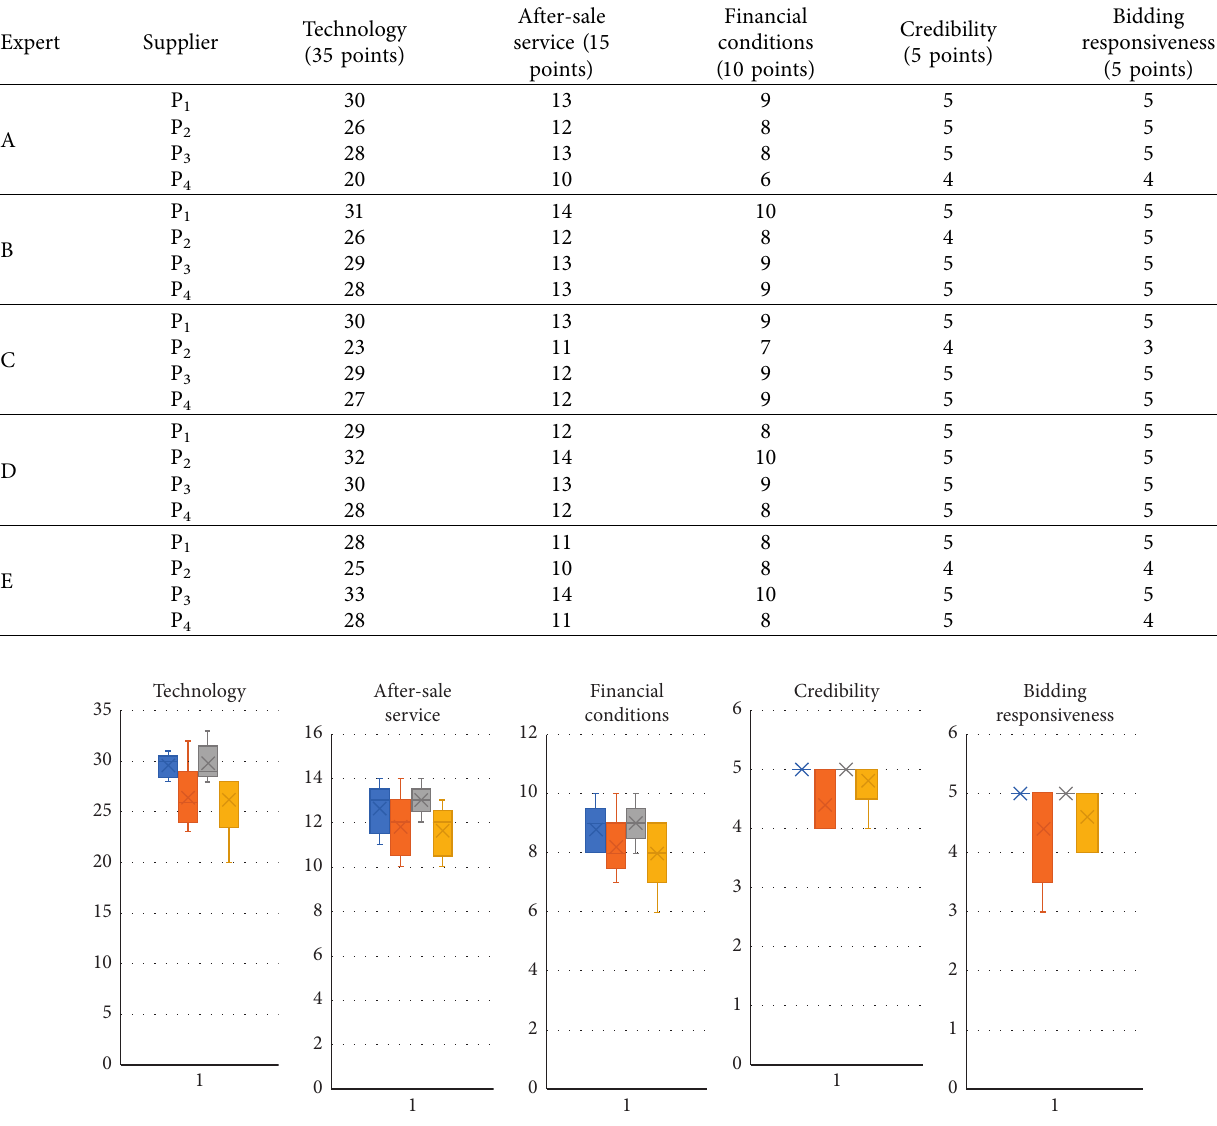
Table 1: Original evaluation data from evaluation experts.